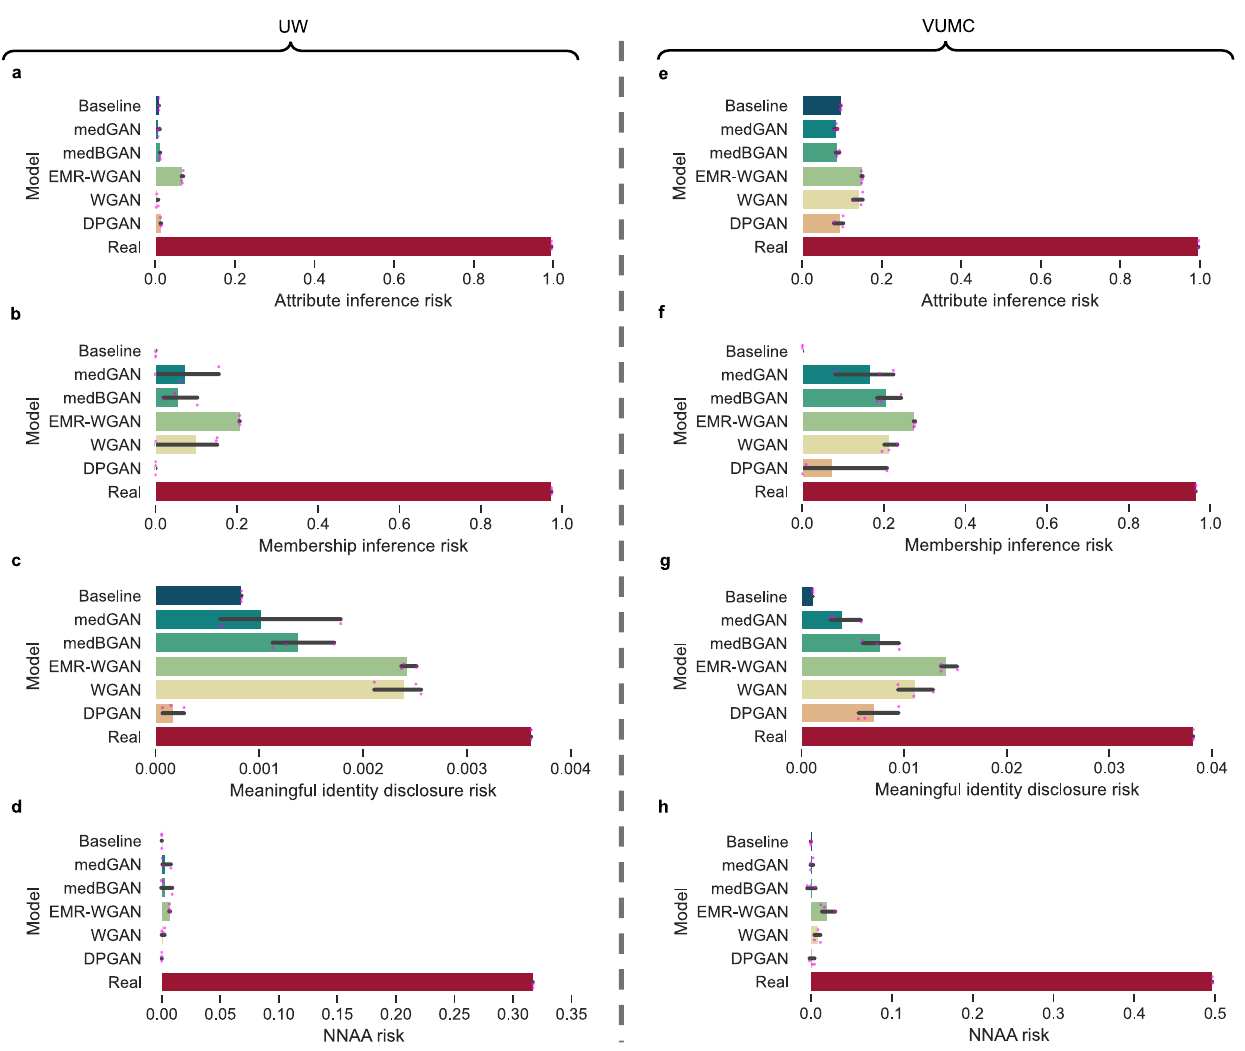
Fig.4|Averageprivacyrisk( n =3)ofthesyntheticversionsoftheUW(a – d)and VUMC(e-h) datasets. a , e Attribute inferencerisk. b , f Membership inference risk. c , g Meaningful identity disclosurerisk. d , h Nearestneighboradversarial accuracy